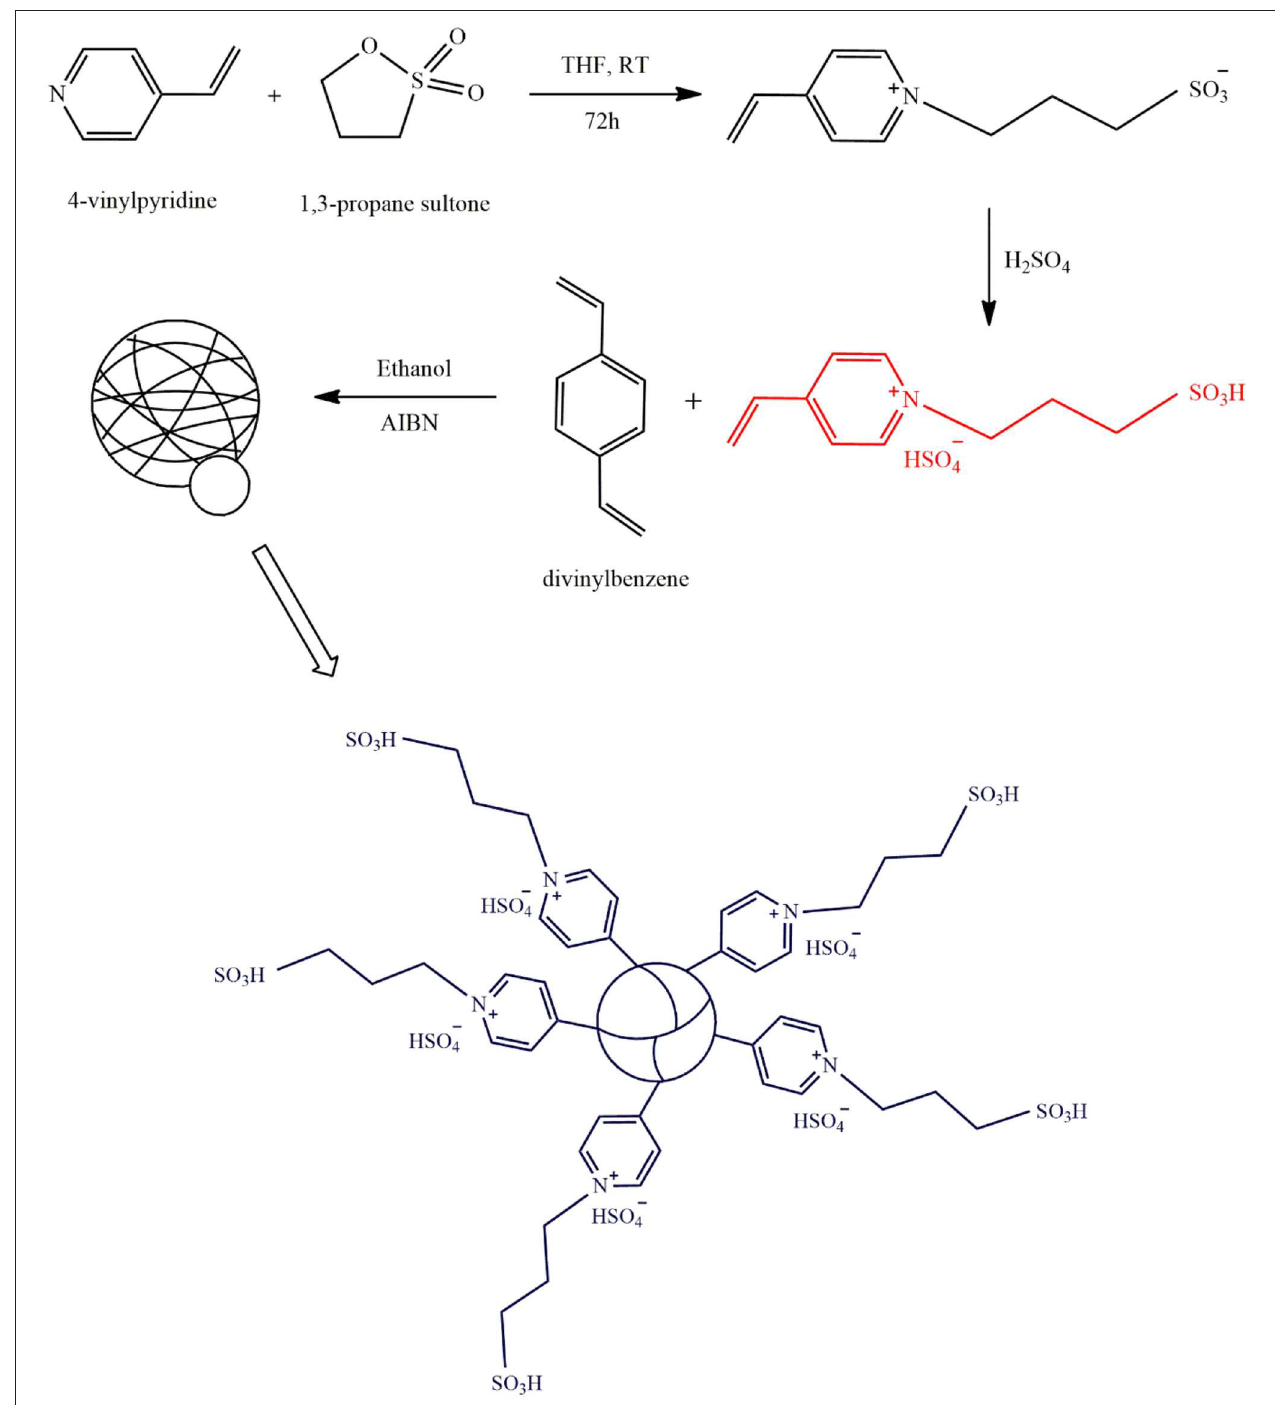
FIGURE 5 | The synthesis procedure of mesoporous acidic PIL [Redrawn with modification from Liang (2013a)].